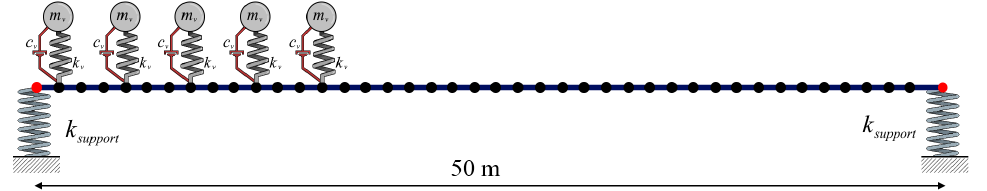
Figure 3. Overview of the numerical